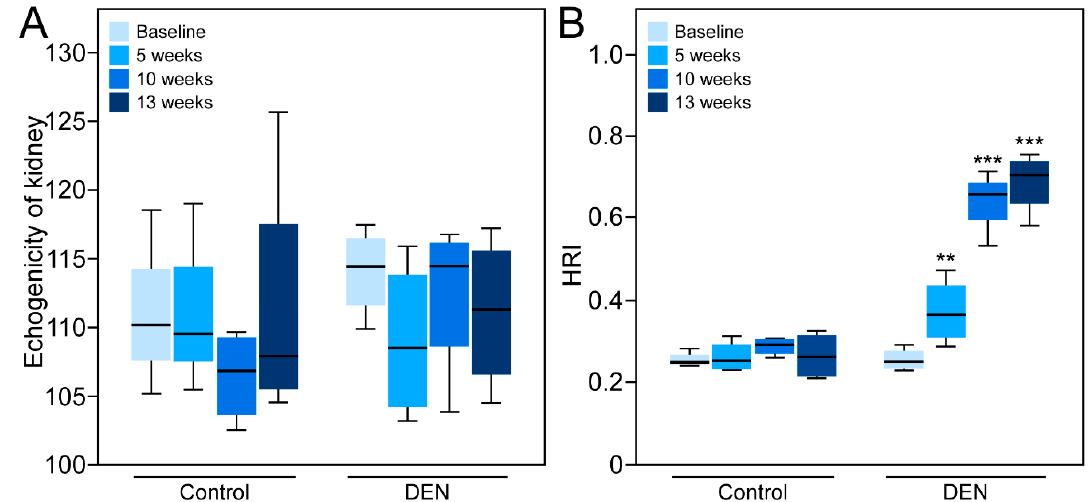
Figure 6. Quantitative analyses of the hepatorenal index (HRI). ( A ) Boxplots showing distribution of echogenicity values of the right kidney obtained from 12 rats prior to the start of DEN consumption (baseline) and 5, 10, and 13 weeks after DEN administration. Echogenicity of kidney of both the control and DEN ‐ fed rats did not change with time. ( B ) Boxplots showing distribution of HRI measurements obtained in 12 rats prior to the start of DEN consumption (baseline) and 5, 10, and 13 weeks after DEN administration. Distribution of the data points with the minimum, first quartile, median, third quartile, and maximum are shown. The horizontal line inside the box is the median. As the hepatic fibrosis developed there were statistically significant increases in HRI. The ANOVA p ‐ value for mean values of HRI for baseline versus 5, 10, and 13 week groups were all statistically significant. Control rats showed no increase in HRI over time. Statistical significance was assigned as ** for p ≤ 0.01, and *** for p ≤ 0.001.